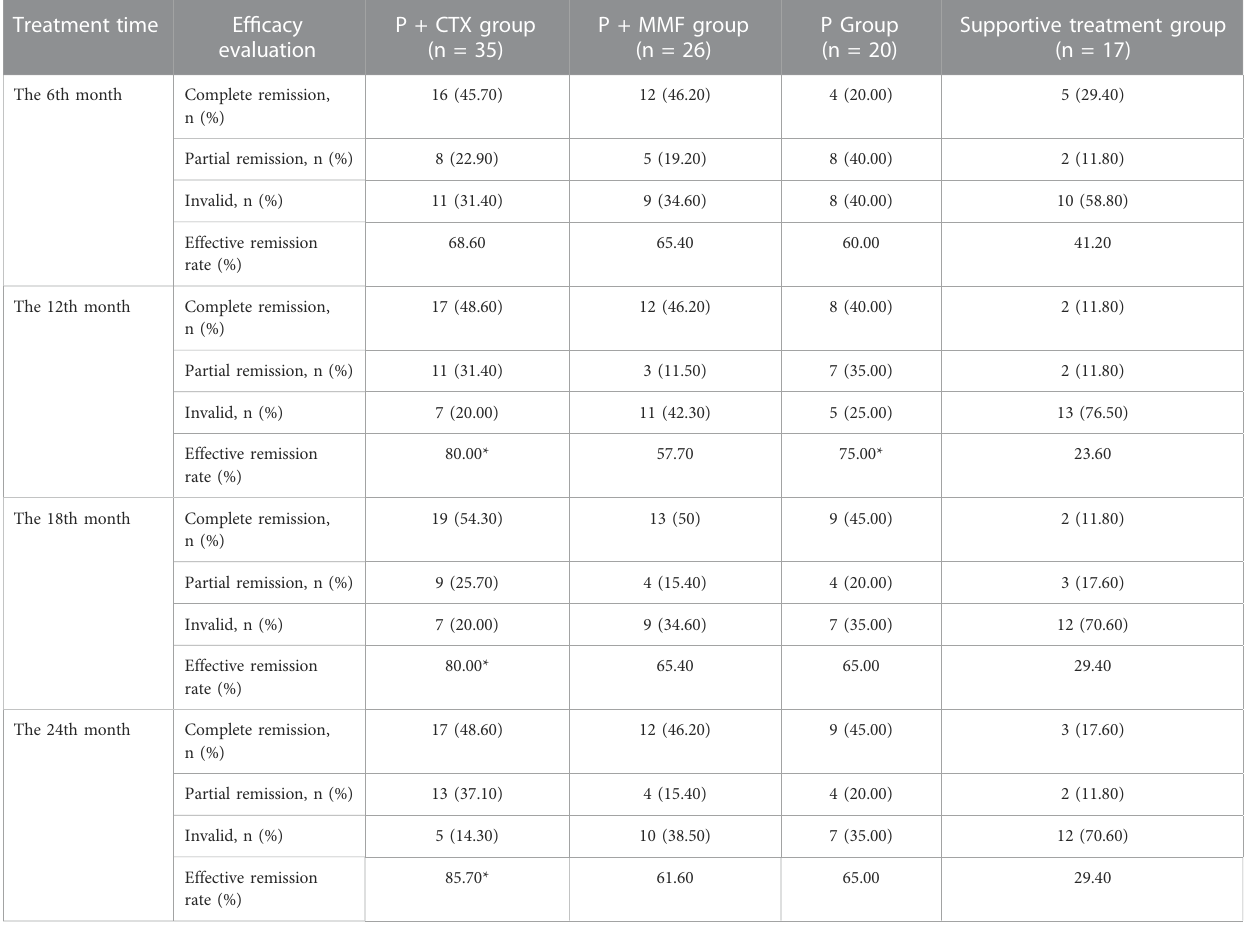
TABLE 7 Comparison of remission in different treatment groups for severe IgAN.